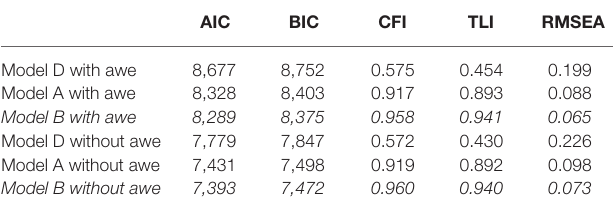
Italization indicates issues in the covariance matrix, the results should not be